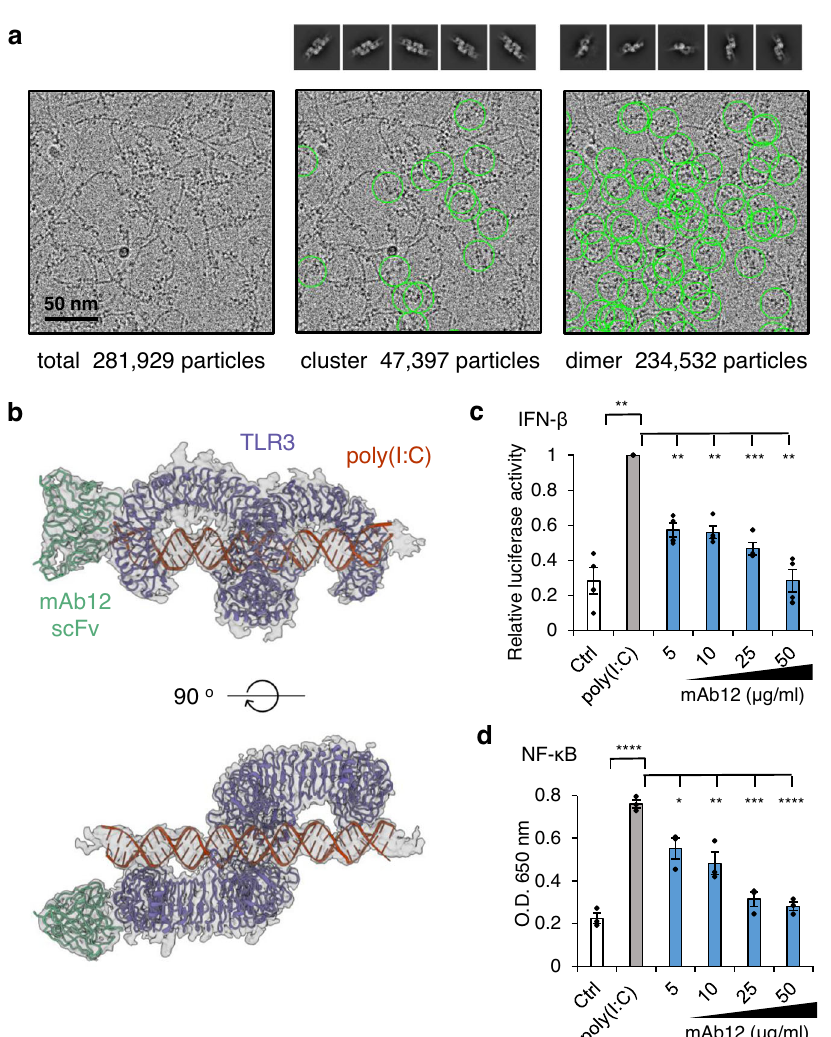
Fig. 4 | Inhibition of ectoTLR3 clustering by a blocking antibody. a Representative micrograph ( n =1116) of the ectoTLR3-mAb12-poly(I:C) complex. AnscFv formof the antibodymAb12isused forthe complexformation. TheTLR3s in the clustered (middle) and dimeric states (right) are marked with green circles. The 2D class averaged images of TLR3 are shown above. The molar ratio of mAb12 vs. TLR3 was 0.5:1. b Atomic model of the ectoTLR3-mAb12-poly(I:C) complex. TLR3-dependent IFN- β ( c ) and NF- κ B ( d ) assays. TLR3 was stimulated by poly(I:C)